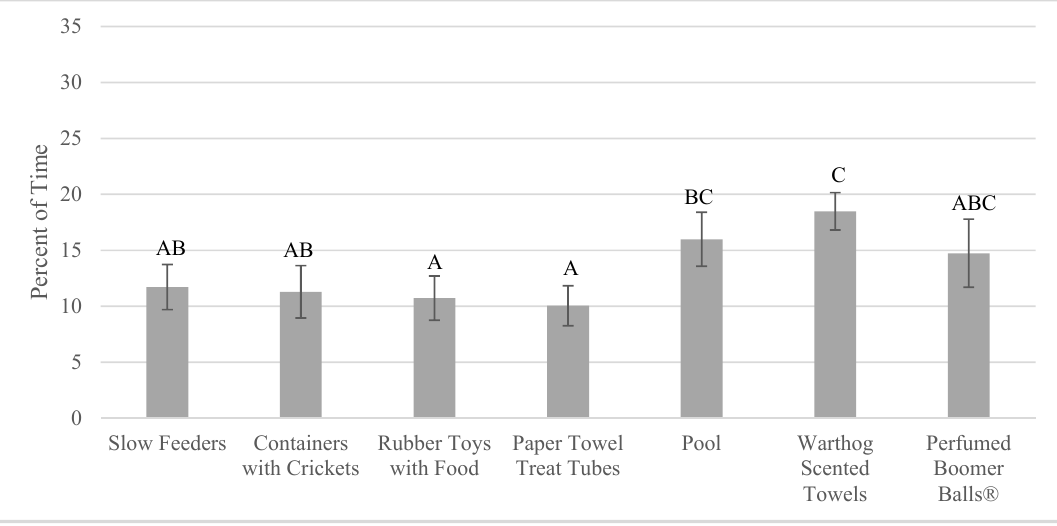
Figure 4. Percent of total time investigating non-food items when each enrichment item was available (mean ± SE; n = 4). Significant pairwise comparisons ( p < 0.05) are noted on the graph with different uppercase letters. Pairwise comparisons can be found in Table S6.